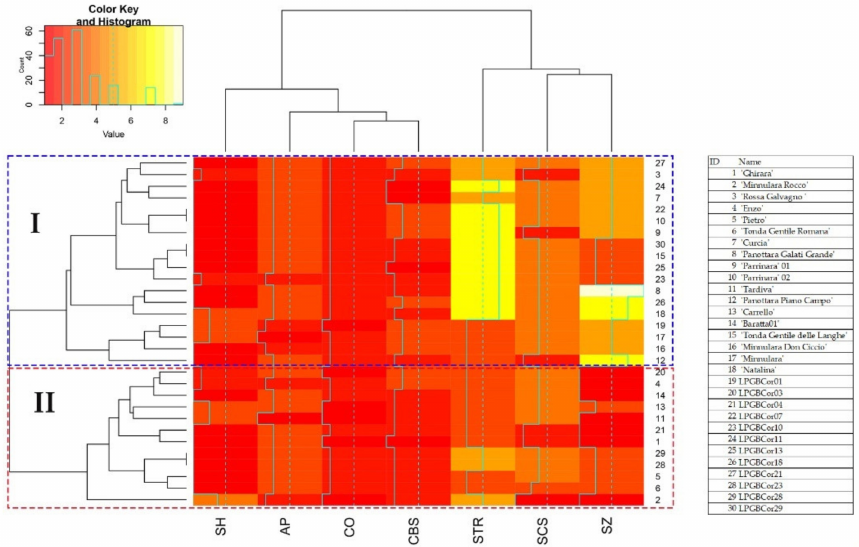
Figure 5. Heatmap clustering of seven nut morphological traits and 30 Sicilian hazelnut genotypes based on Euclidean distances. Red and yellow colors represent reduced and augmented representa- tion levels, respectively. Legend of heatmap is also reported. Cluster I and cluster II are also indicated by dashed